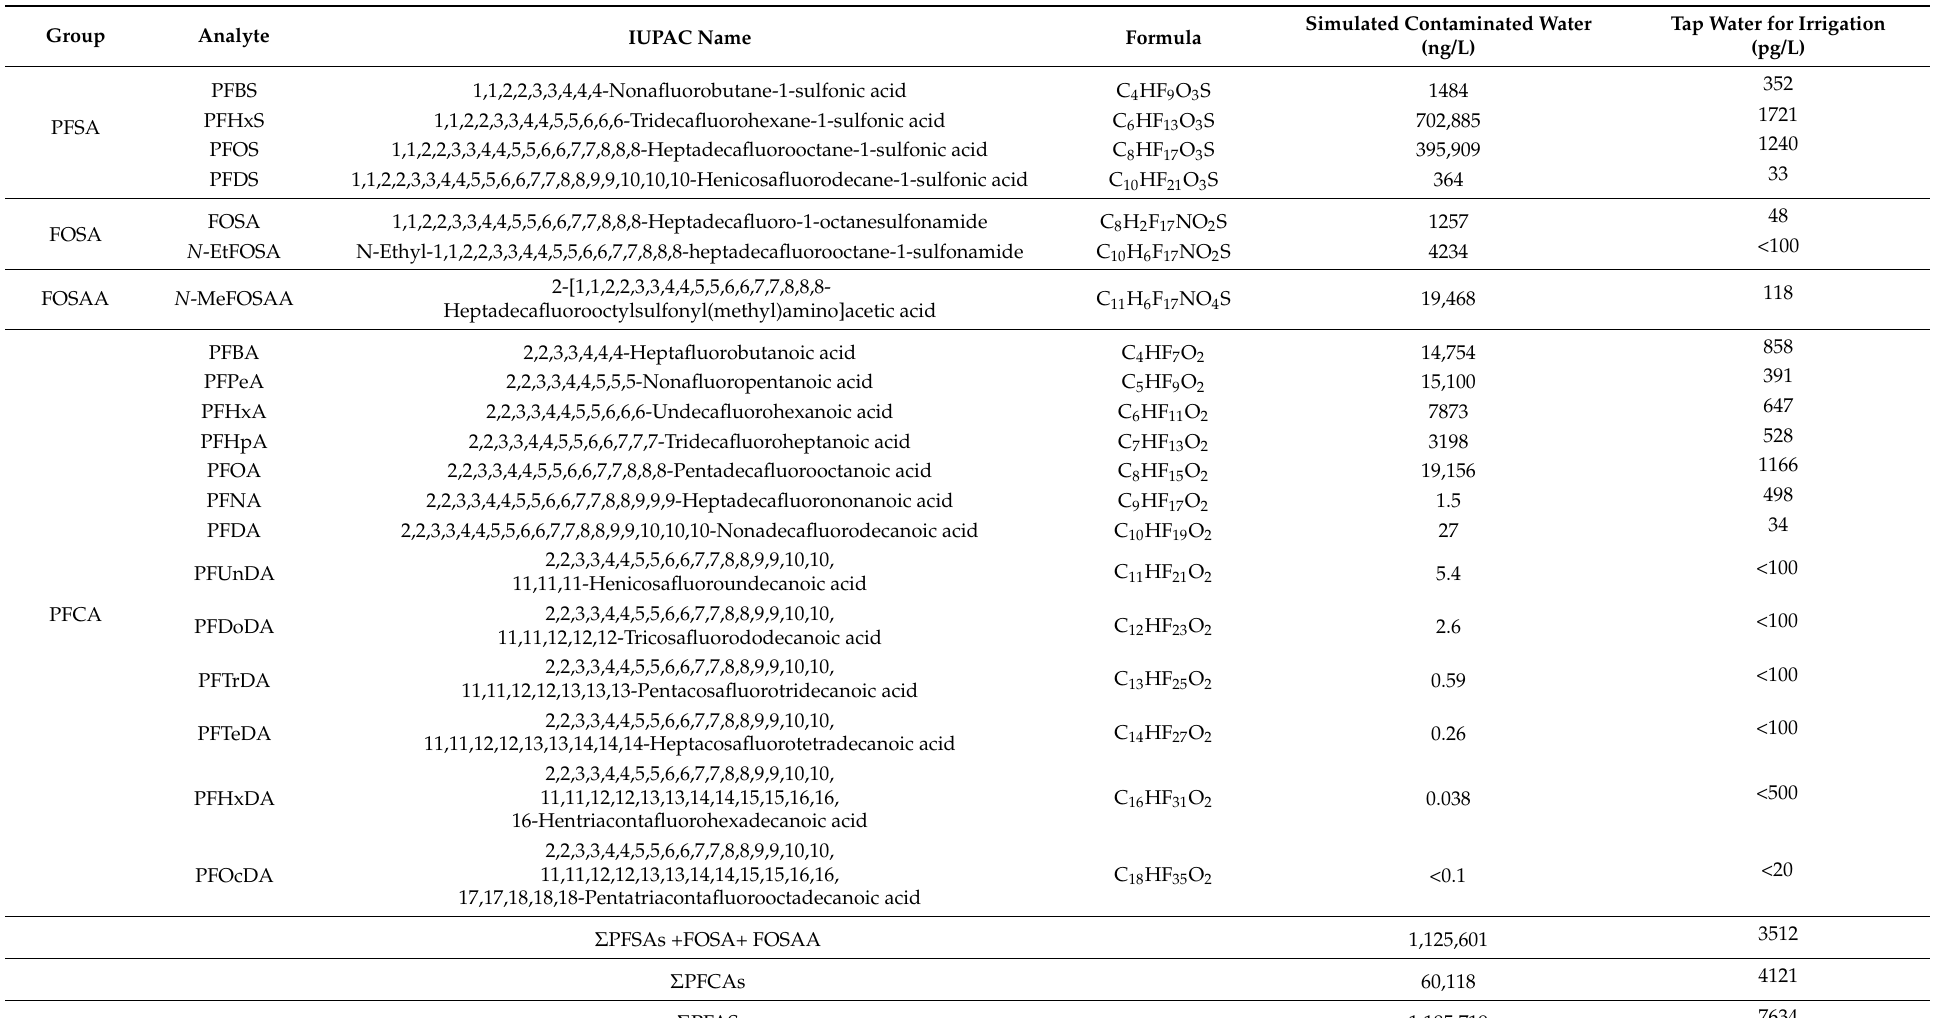
Table 1. Concentrations of PFAS in simulated contaminated water (ng/L) and tap water for irrigation (pg/L) used for the lysimeter